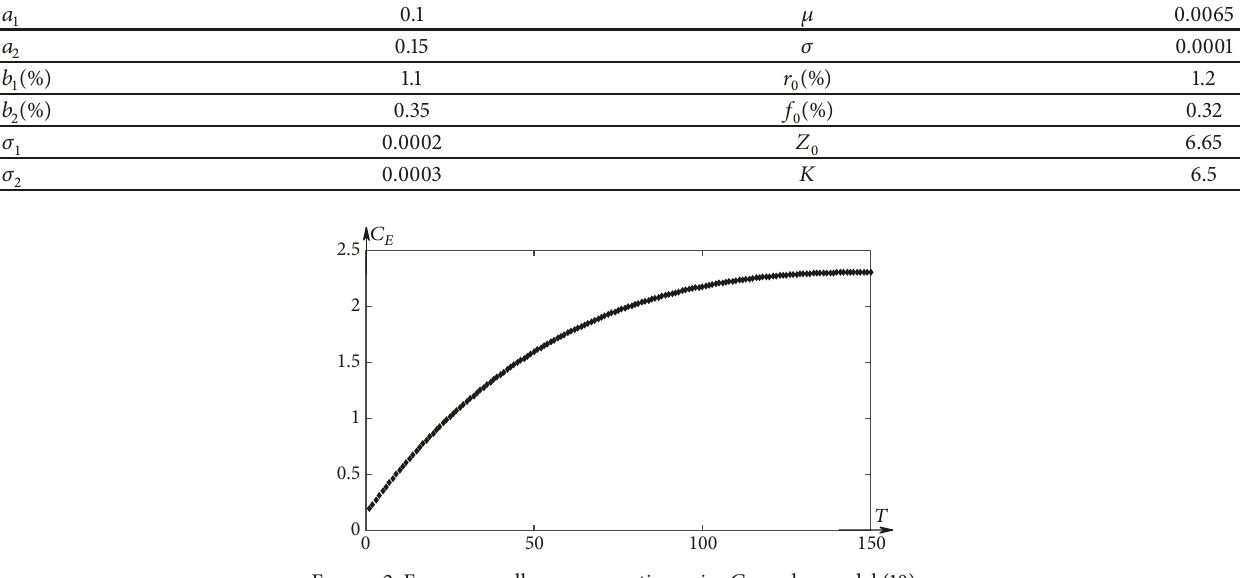
Figure 2: European call currency option price 𝐶 𝐸 under model